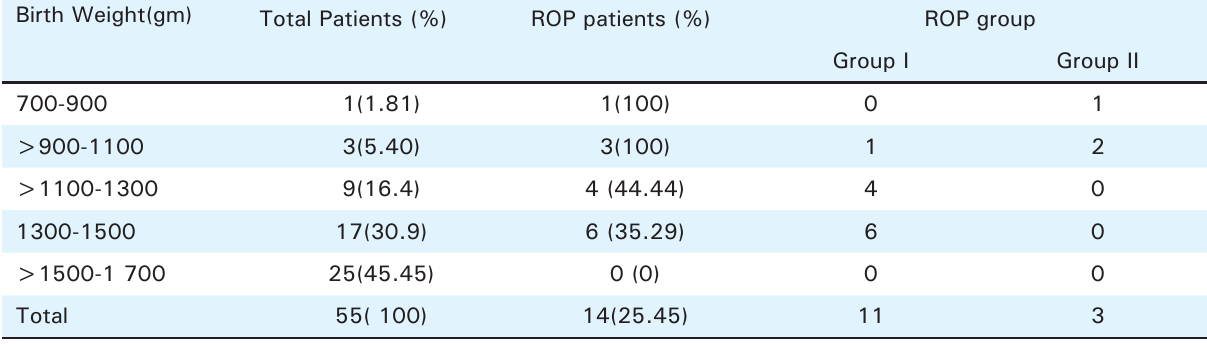
Table 3. Incidence and severity of ROP in relation to birth weight Birth Weight(gm) Total Patients